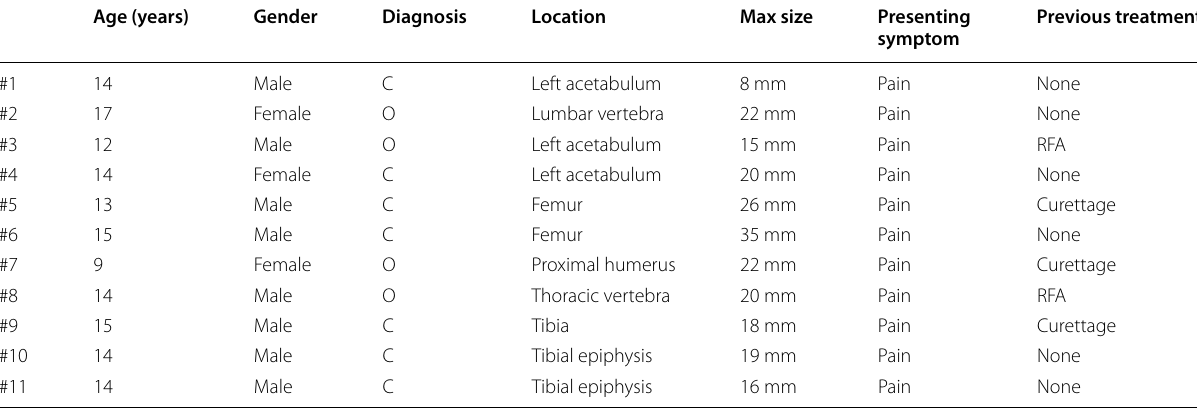
Table 1 Patient demographics, clinical presentation, diagnosis, tumor size, tumor location and previous